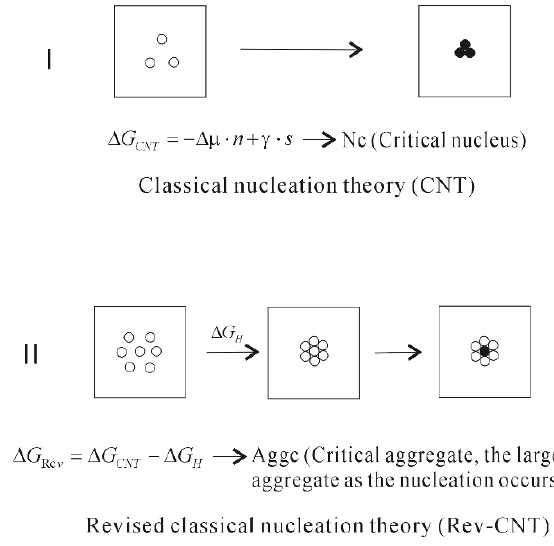
Figure 8. The homogeneous nucleation mechanism of dissolved solutes in water. The dissolved behaviors of NaCl in water are dependent on ion concentrations, which affect the nucleation mechanism of NaCl crystal in water. Because of the formation of solute aggregate, this reduces the height of nucleation barrier.